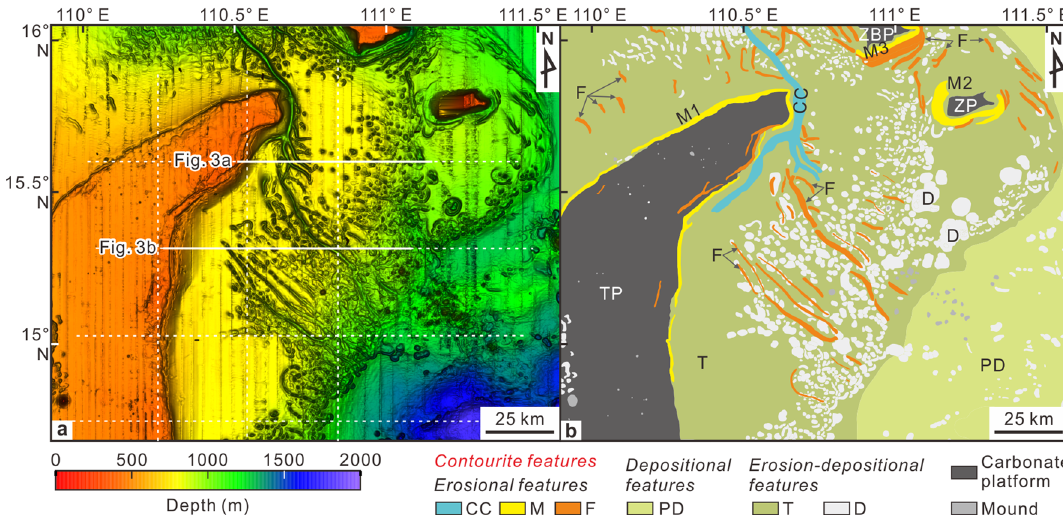
Figure 2. (a) Multibeam bathymetric map; and b) Morphosedimentary interpretation including large features. White lines in “a” show seismic lines position in this study. CC contourite channel, M moat, F furrow, PD plastered drift, T terrace, D depression. Maps were generated using Surfer software (version 13, https ://www. golde nsoft ware.com/produ cts/surfe r) and CorelDraw Graphics Suite X8 (https ://www.corel